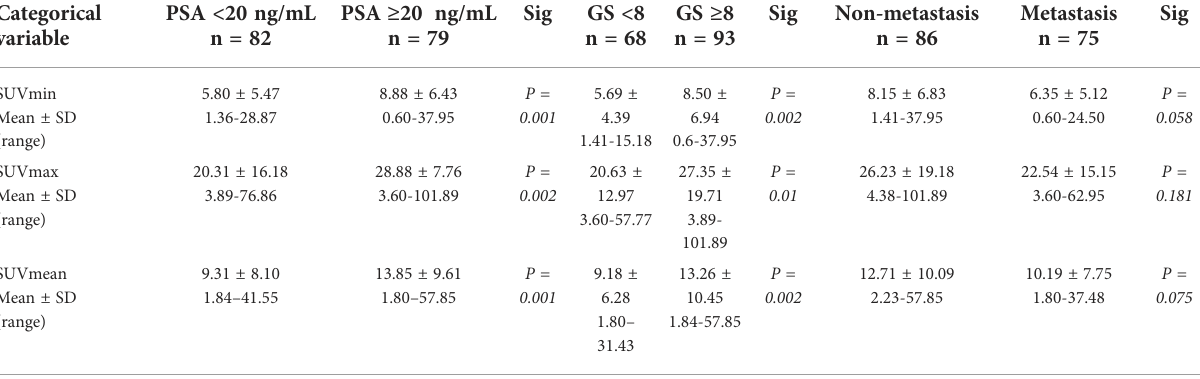
TABLE 2 18F-PSMA-1007 PET/CT parameters for different PSA, Gleason score, and metastasis status subgroups. Categorical variable